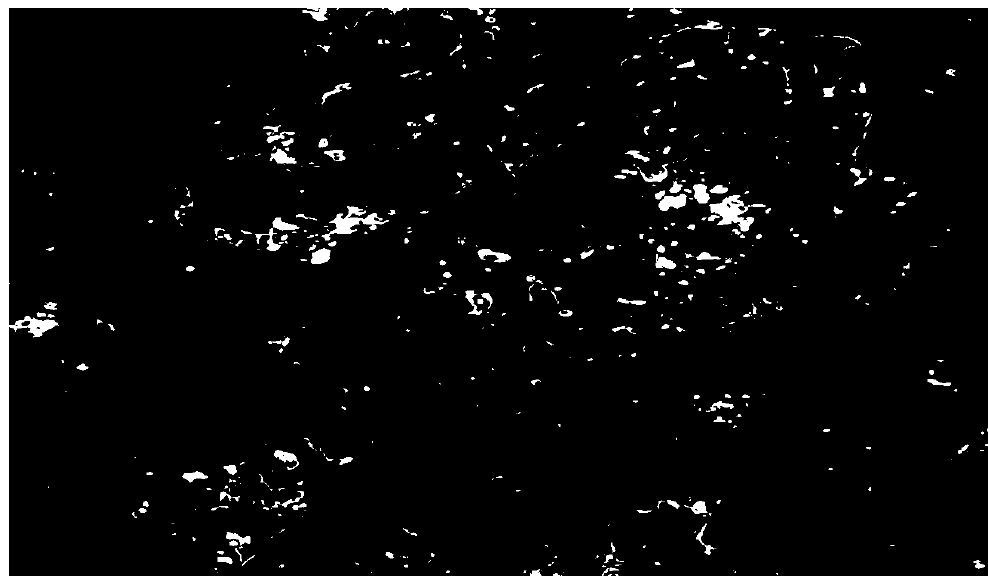
Figure 10. Final detected positive and negative